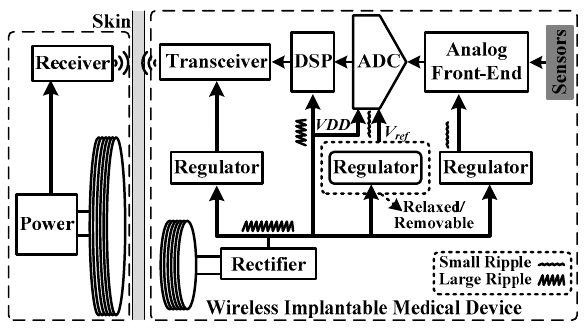
Figure 1. Block diagram of a typical wireless implantable medical device.